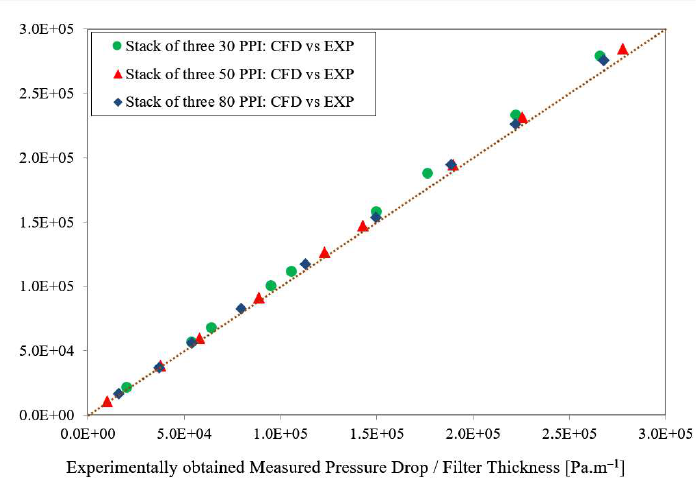
Figure 12. A comparison between the mathematically and empirically obtained pressure drops over the filter thickness values for stacks of three 30, three 50 and three 80 PPI CFFs. the filter thickness values for stacks of three 30, three 50 and three 80 PPI